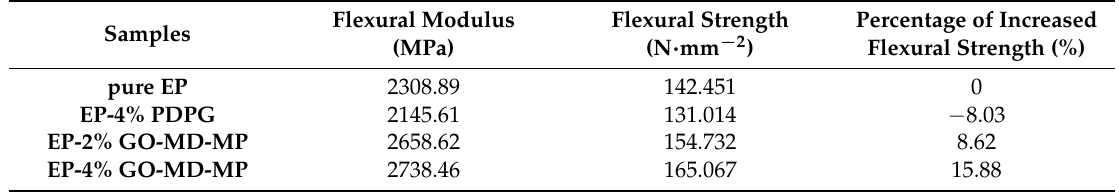
Table 3. Flexural modulus (MPa) and flexural strength (N · mm − 2 ) of cured EP and its